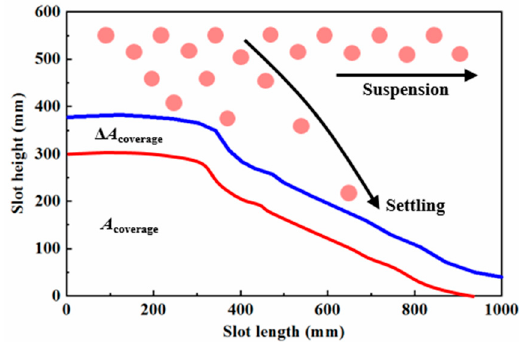
Figure 2. Schematic of the placement area and its increment in the slot.